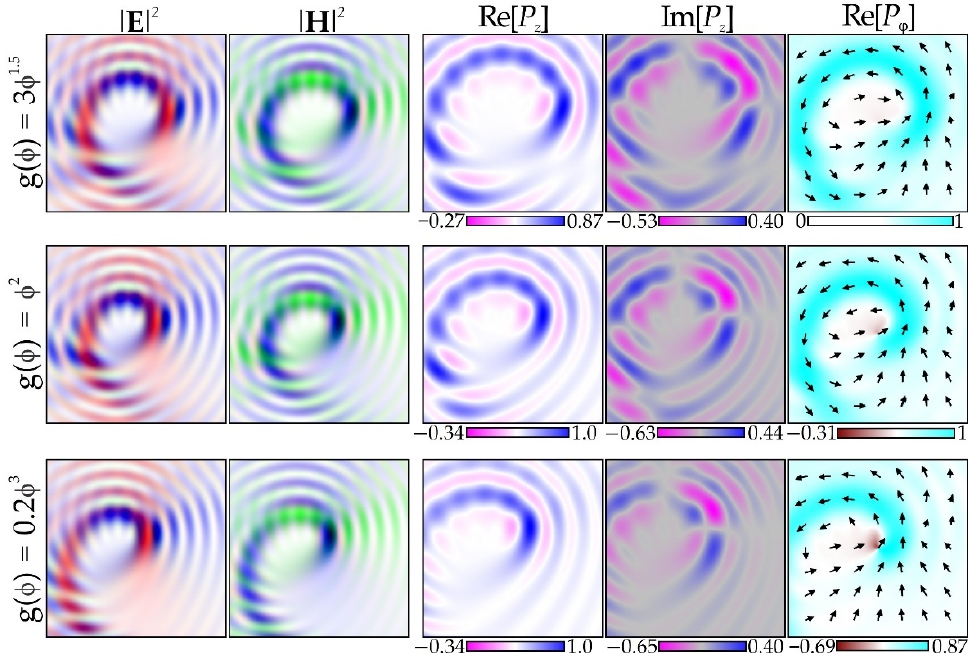
Figure 4. Simulation results for PEPPs exp( im ϕ s ) (red color—for x -components, green color—for y -components, and blue color—for z -components). The distributions in the focal plane with a size of 6 λ × 6 λ are shown.